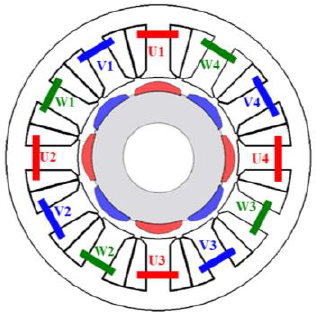
Figure 3. Configuration of developed a base model.